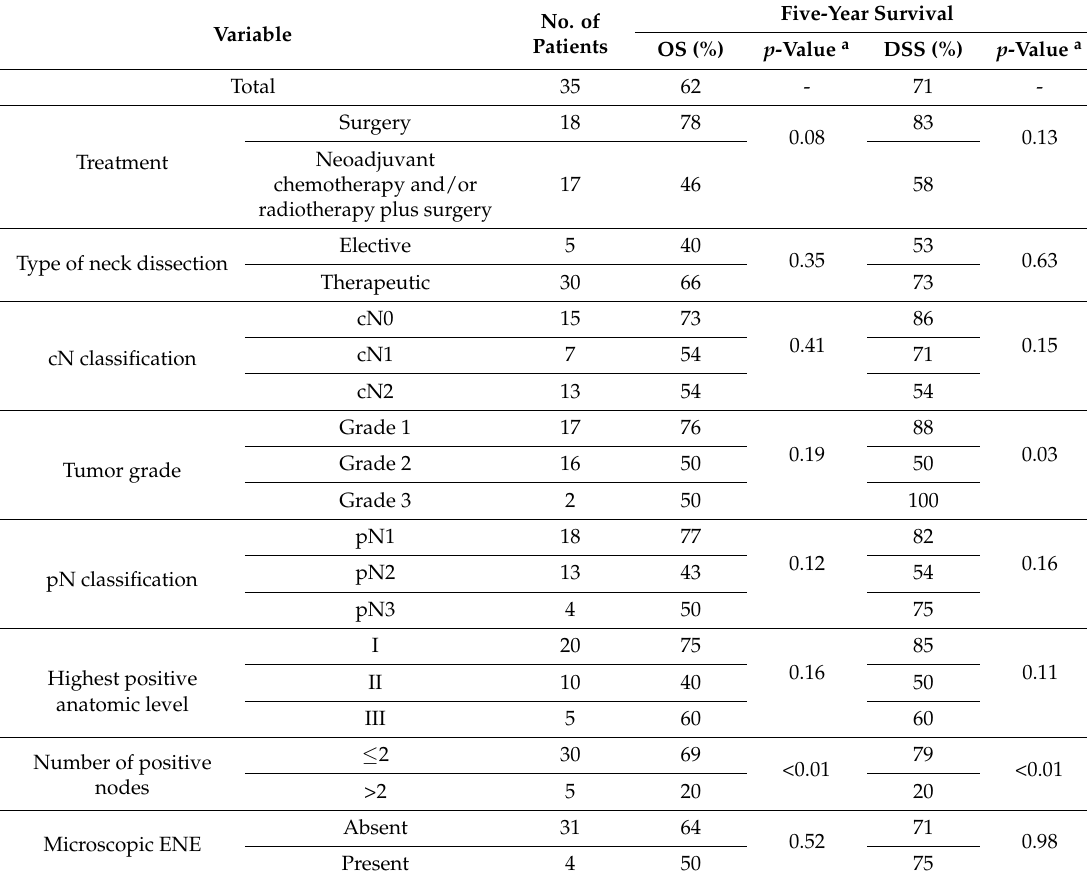
Table 4. Treatment, pathologic variables and five-year survival in 35 pN+ OSCC patients who underwent SND